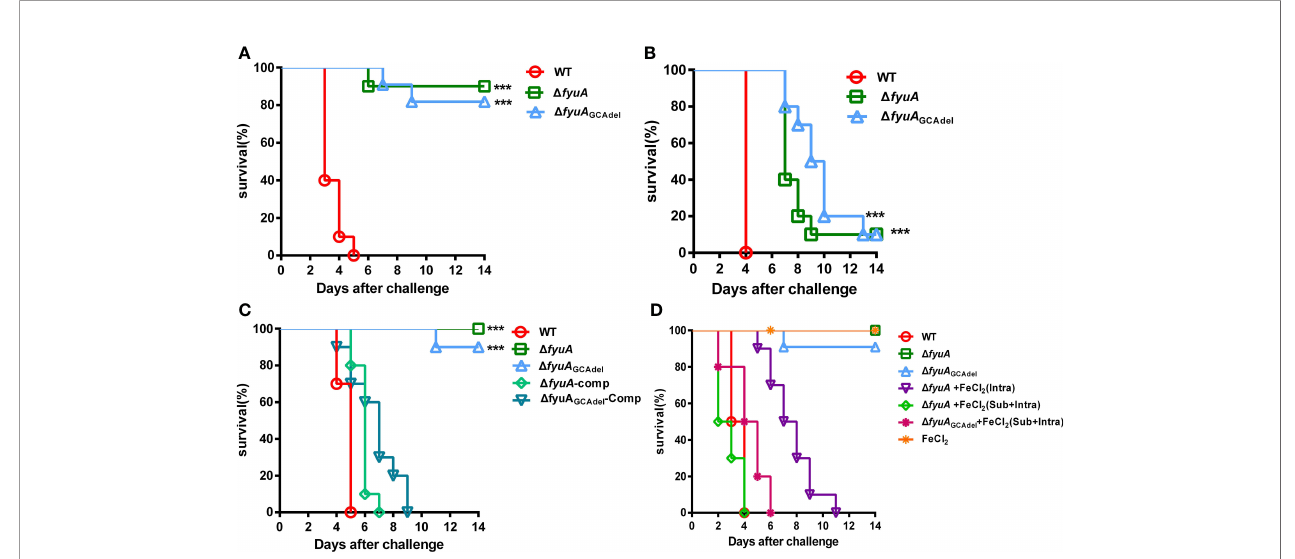
FIGURE 3 | Y. pestis D fyuA and D fyuA GCAdel mutants showed virulence attenuation in mice, and iron accelerated the mouse lethality during subcutaneous infection with D fyuA and D fyuA GCAdel mutants. Each mouse of each group (n = 10) was challenged with 10 4 CFU of bacteria. (A) Intraperitoneal challenges with WT, D fyuA , or D fyuA GCAdel . (B) Intravenous challenges with WT, D fyuA , or D fyuA GCAdel . (C) Subcutaneous challenges with WT, D fyuA , D fyuA GCAdel , and the complemented strains of the two mutants. (D) The WT, D fyuA , and D fyuA GCAdel groups were subcutaneously challenged with WT, D fyuA , or D fyuA GCAdel respectively. The FeCl 2 groups were challenged with the mutants and were supplemented with 50 m g of FeCl 2 intraperitoneally or subcutaneously plus intraperitoneally. ***, p <